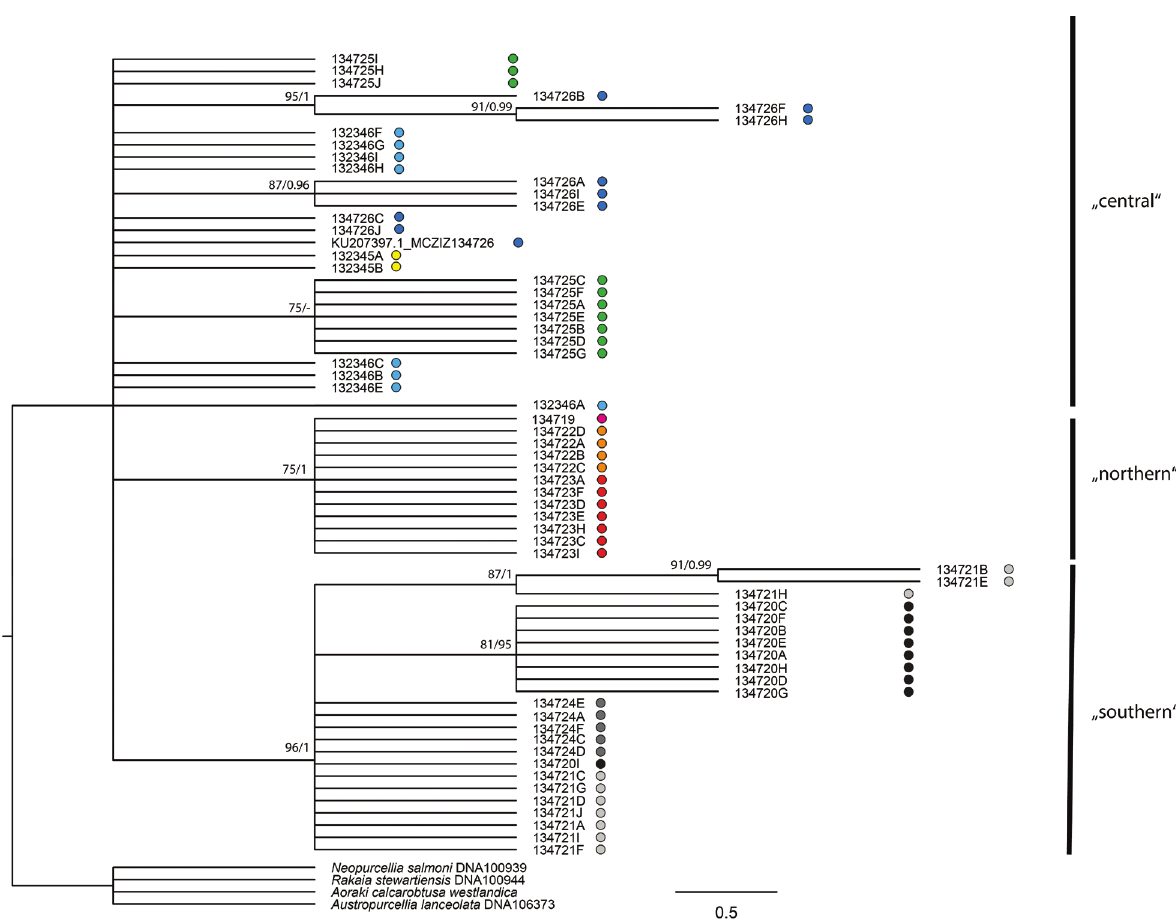
Figure 2. Phylogenetic relationships. The depicted phylogenetic tree is based on the maximum likelihood analysis. Bootstrap sup- port from maximum likelihood as well as posterior probabilities from the Bayesian analysis are depicted on the respective branches. Colors correspond to the respective localities (compare Fig. 1).